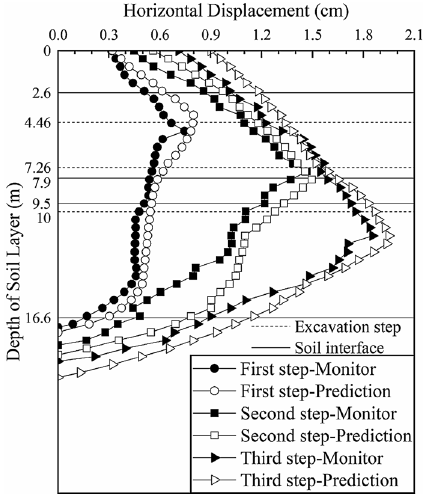
Figure 12. Deep horizontal displacement of section 3 before the inversion.